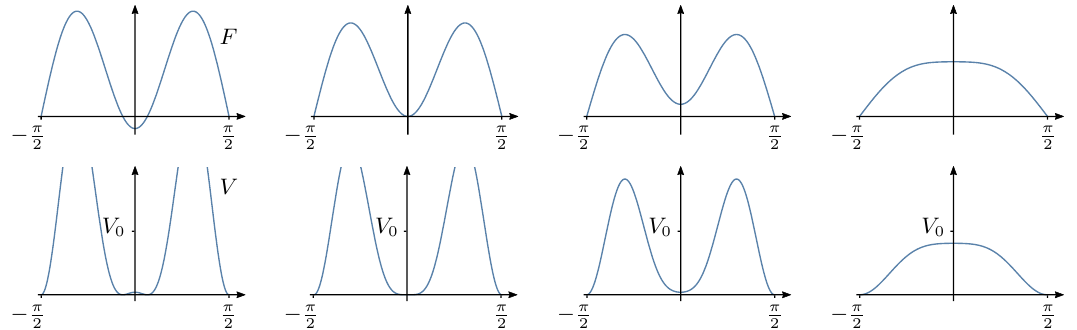
Figure 2 . The F -term ∝ [cos( ϕ ) − α cos(3 ϕ )] (upper panels) and corresponding scalar potential V 0 [cos( ϕ ) − α cos(3 ϕ )] 2 (lower panels) for α = 1 . 2 , 1 , 0 . 8 , 0 . 1 from left to right. By tuning α we find local minima at arbitrarily small positive value (third column). If α becomes too small the minima disappear (fourth